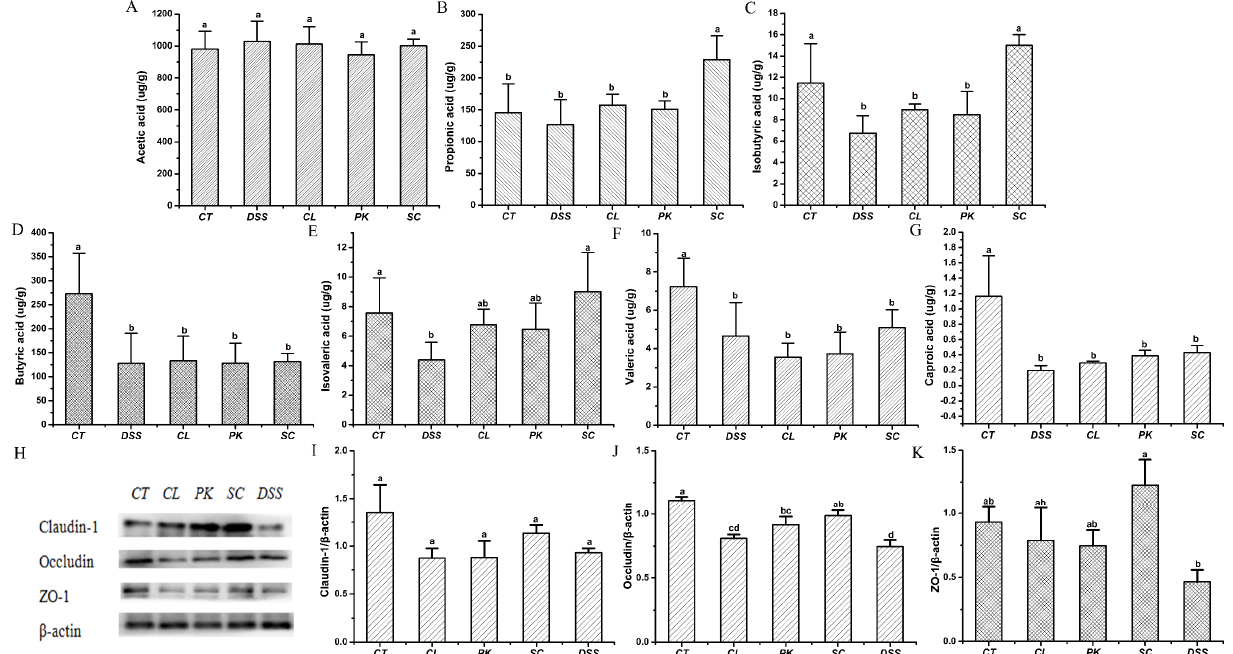
Figure 5. Effects of three yeast strains on the short-chain fatty acid contents and barrier proteins of the conlon in Balb/c mice in different groups. ( A – G ) Acetic acid, Propionic acid, Isobutyric acid, Butyric acid, Isovaleric acid, Valeric acid, Caproic acid; ( H ) Western blotting images of Claudin–1, Occludin and ZO–1. Relative expression of ( I ) Claudin 1, ( J ) Occludin, ( K ) ZO–1. Different lowercase letters marked on the column represent significant difference ( p < 0.05).